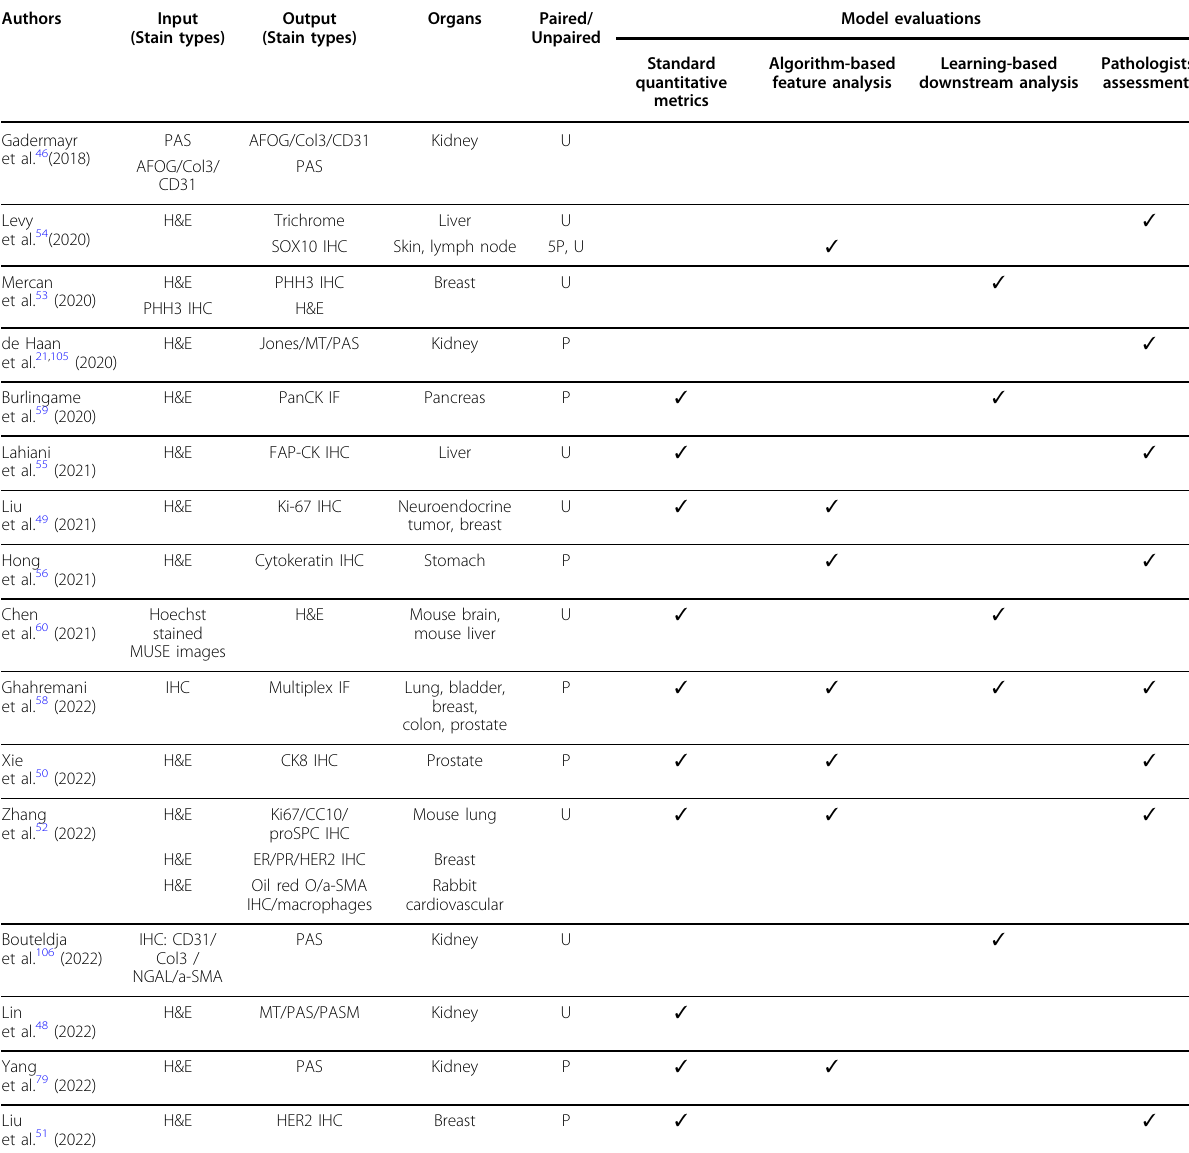
Staining abbreviations: FAP-CK Fibroblast Activation Protein and Cytokeratin, CC10 Clara cell 10, proSPC Anti-Prosurfactant Protein C, ER Estrogen receptor, PR Progesterone receptor, PASM Periodic